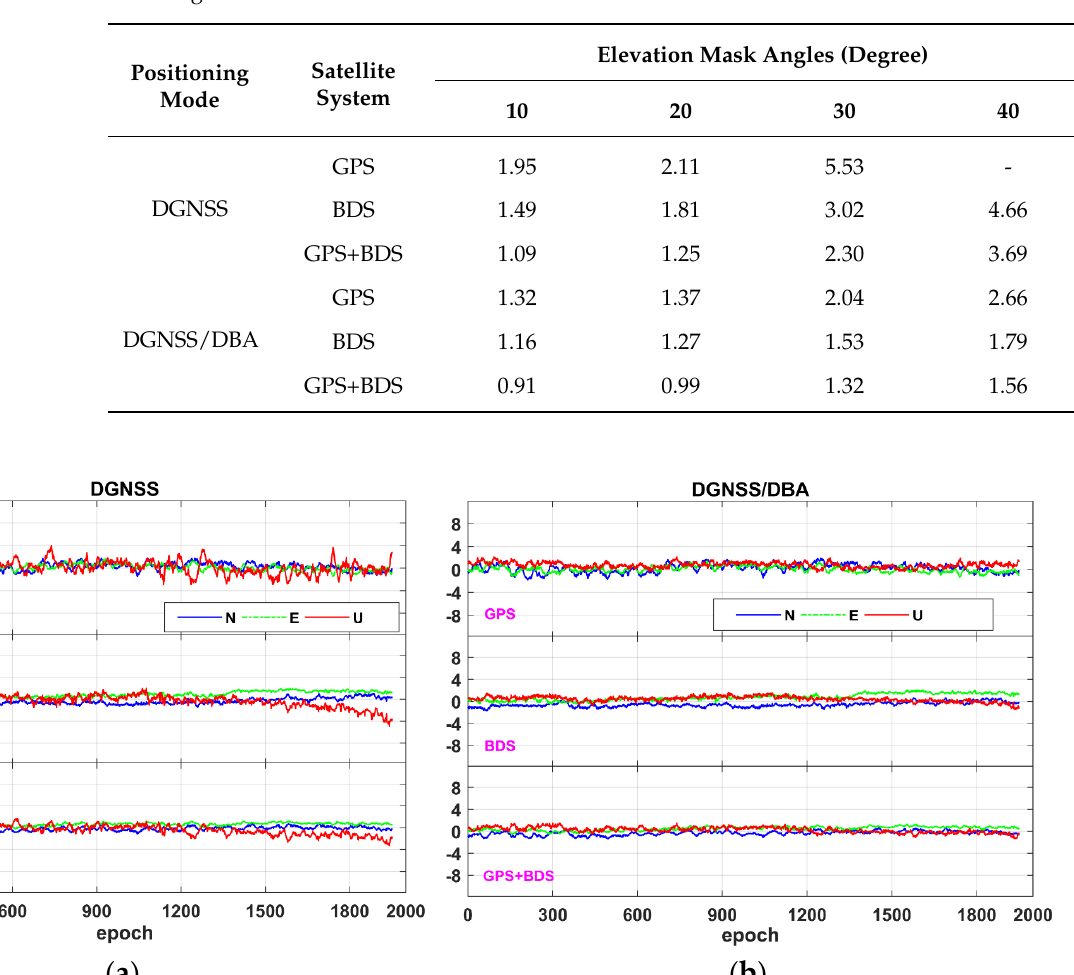
Table 3. The average PDOP values for DGNSS and DGNSS/DBA modes at different elevation mask angles.